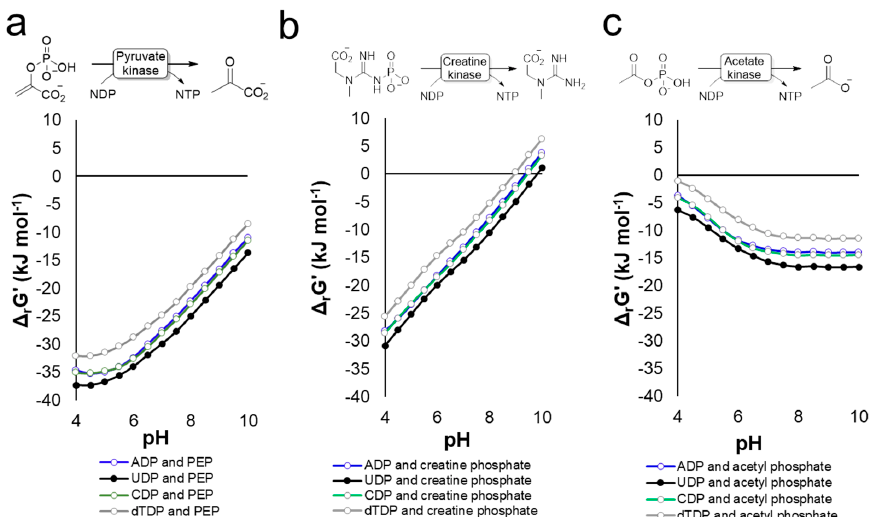
Figure 8. The use of different energy-rich phosphate donors to regenerate NTP using either pyruvate- ( a ), creatine- ( b ), or acetate kinase ( c ). The Δ r G’° represents the standard change of Gibbs free energy and was calculated using the eQuilibrator web interface (http: // equilibrator.weizmann.ac.il) [155] using the following conditions: ionic strength 0.1 M, pH 7.0, 1 mM of component, 298